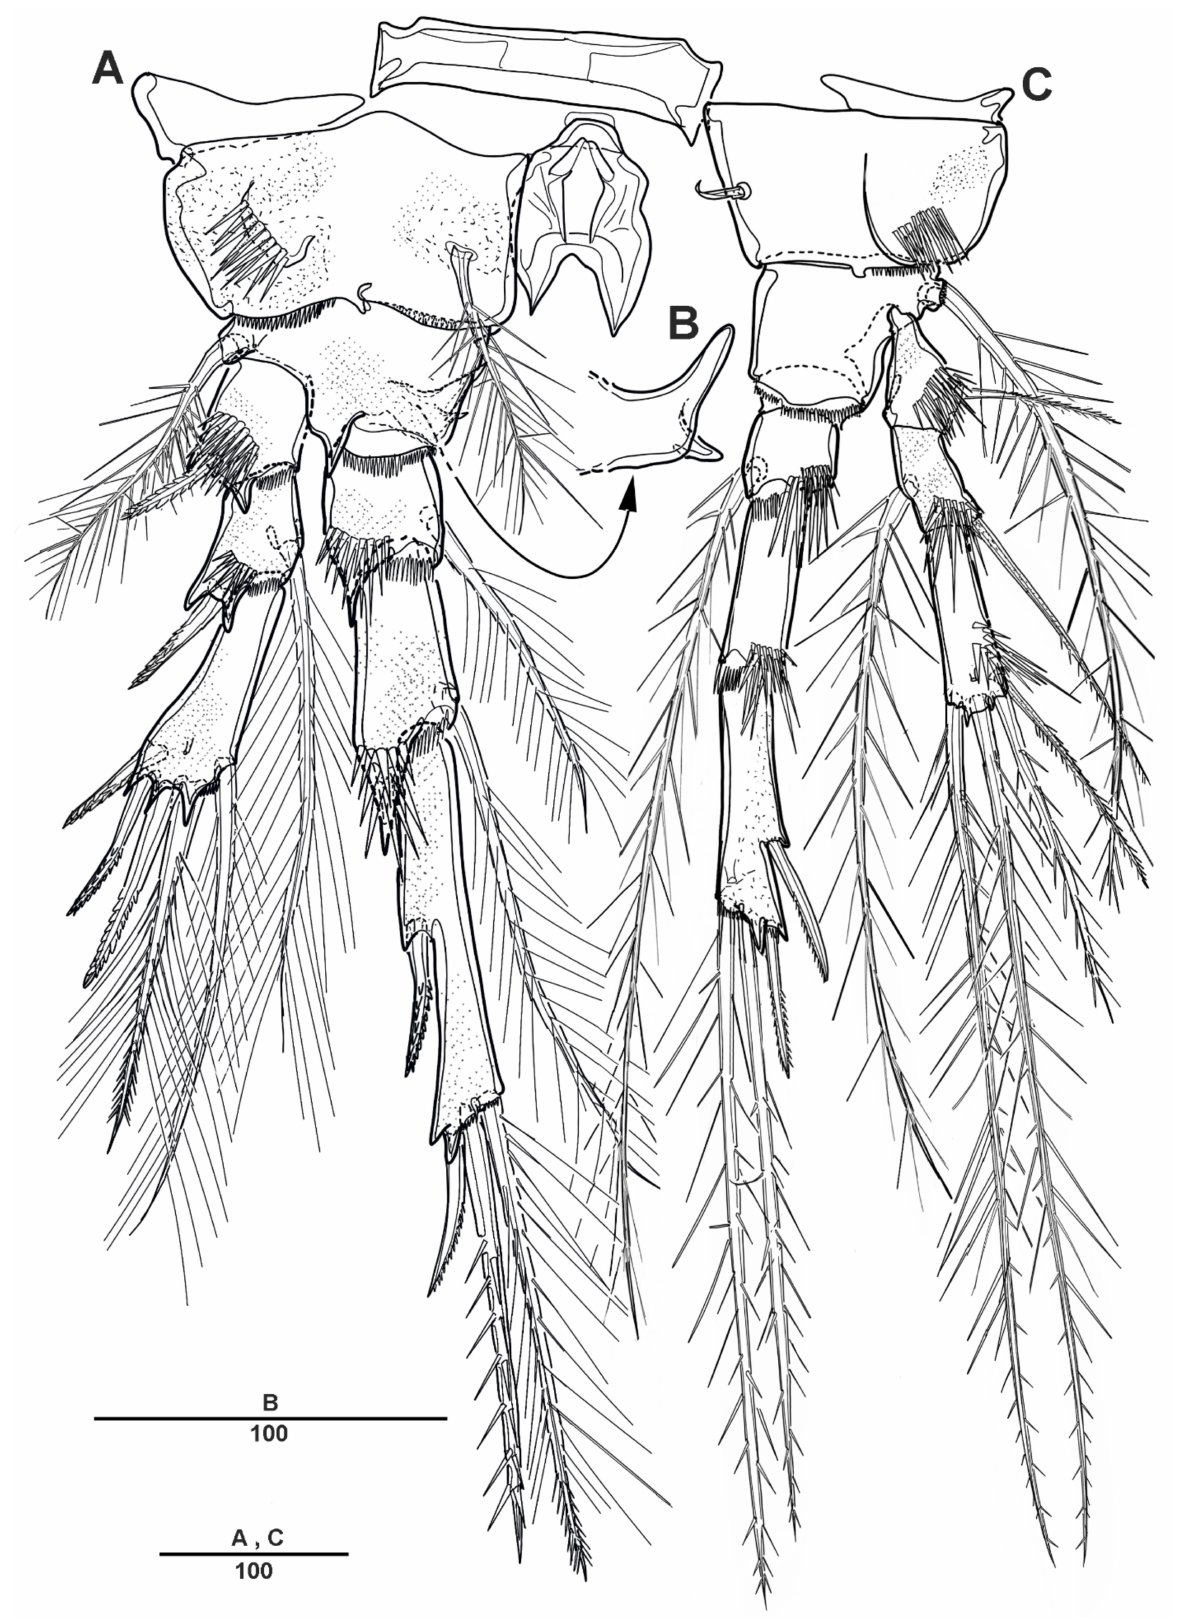
Figure 7. Scottolana daecheonensis sp. nov. holotype female: ( A ) P3, anterior; ( B ) P3, basal inner process; ( C ) P4, anterior. Scale bars in µ